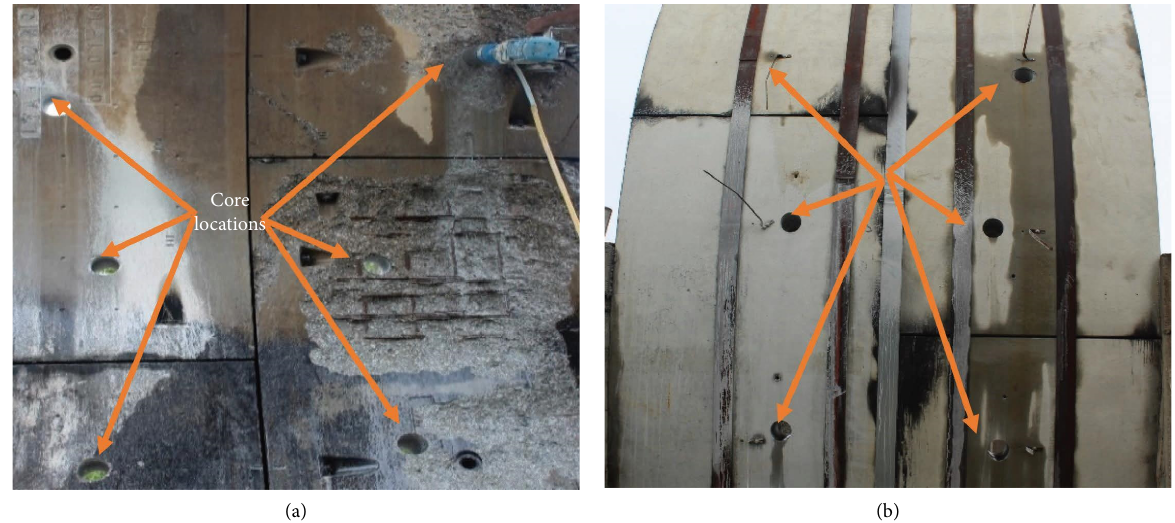
Figure 4: Coring drill locations in the full-scale segments for MYC and SPC concrete tunnels; (a) inner surface view and (b) outer surface view.